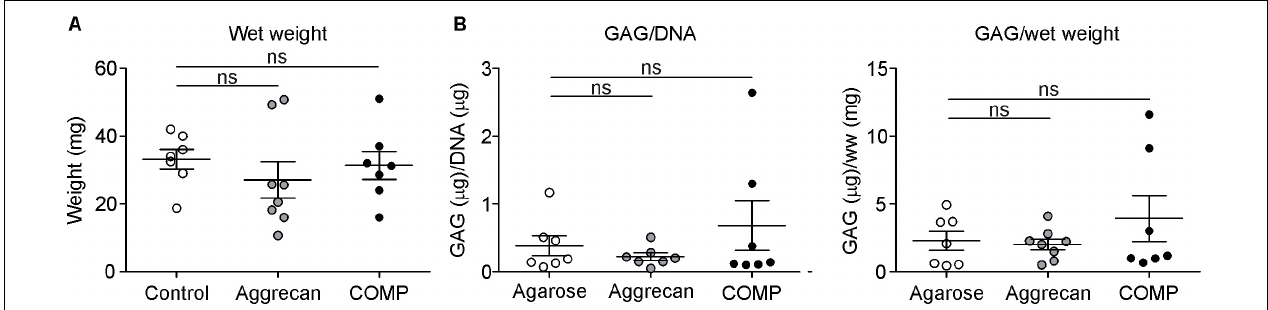
FIGURE 3 | Similar GAG content in cartilage generated out of periosteum in vivo . Cartilage formation was ectopically induced by injecting an agarose biogel ( n = 7) with or without the addition of Aggrecan (2% w/v; n = 8) or COMP (0.5 mg/ml; n = 7) under the tibial periosteum of rabbits and after 14 days generated tissue was harvested for analysis. (A) Wet weight was determined for each ectopically generated cartilaginous tissue. (B) GAG content corrected for DNA content (left panel) or for wet weight (right panel) was determined in samples from (A) . Each dot represents the determined value for each of these individual generated tissues per group and lines in graphs indicate mean ± SEM. Statistically significant differences ( p < 0.05) are shown by an *, ns = not significant.